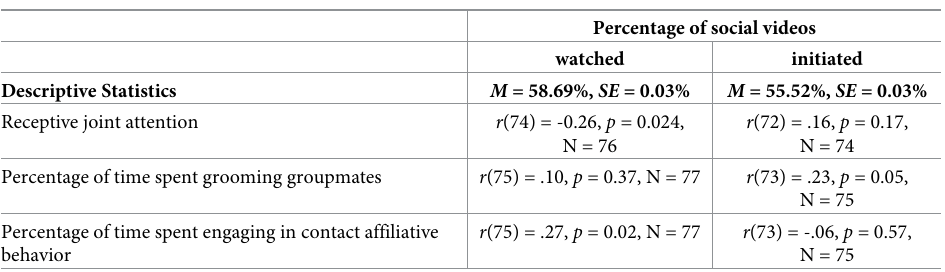
Table 1. Descriptive Statistics M = 58.69%, SE = 0.03% M = 55.52%, SE = 0.03% Receptive joint attention r (74) = -0.26, p = 0.024, Percentage of time spent grooming groupmates r (75) = .10, p = 0.37, N = 77 r (73) = .23, p = 0.05, Percentage of time spent engaging in contact affiliative behavior Descriptive statistics for percentage of social videos watched and initiated, and correlations between these measures and both social cognition and